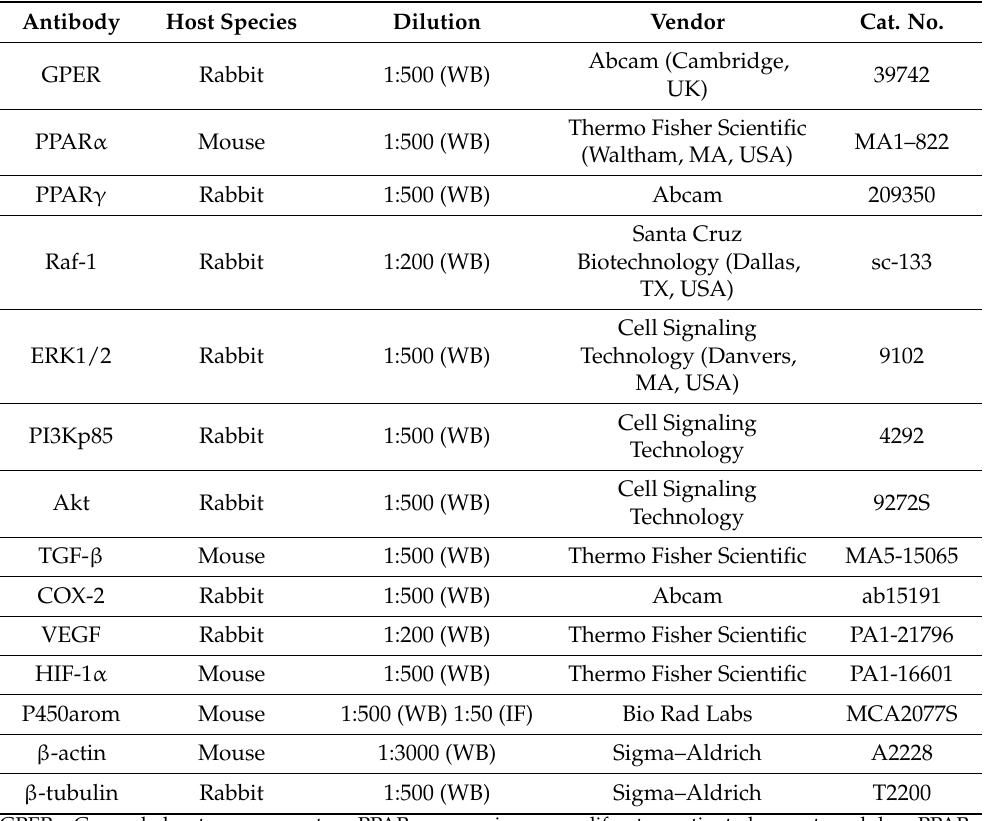
Table 1. Details for primary antibodies used for Western blotting and